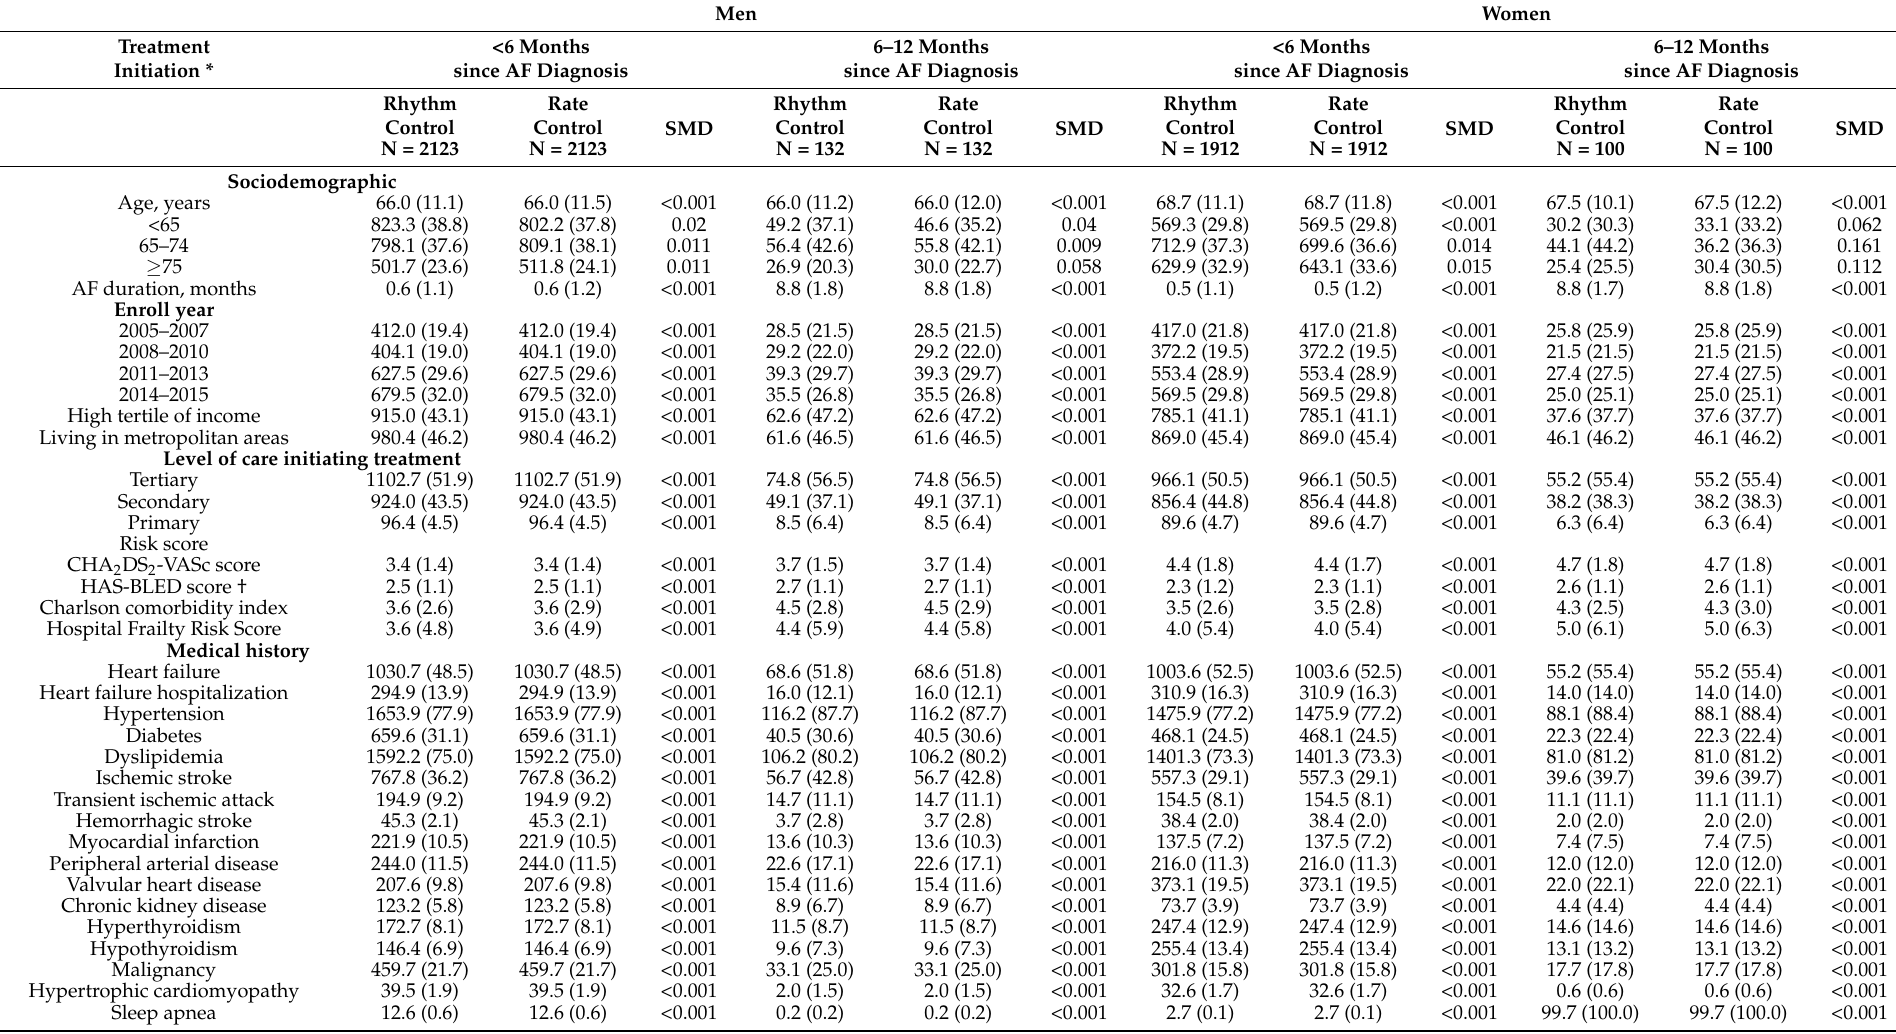
Table 2. Baseline characteristics of men and women treated with rhythm- or rate control after overlap